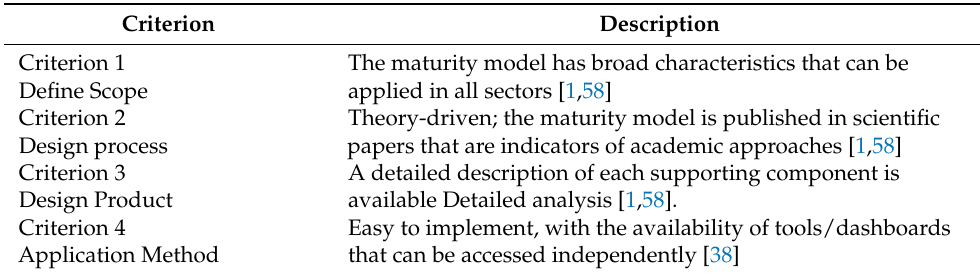
Table 1. Criteria used in the evaluation of existing